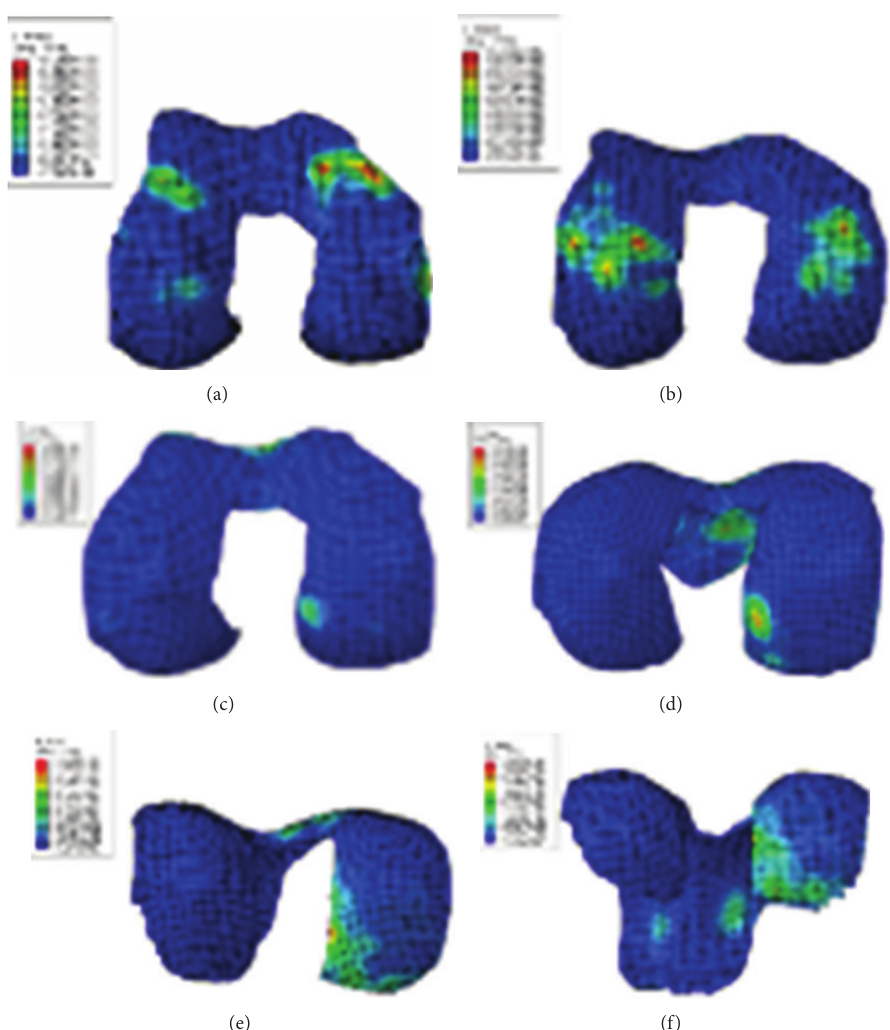
Figure 12: Contact stress of 0-30-60-90-130 degree flexion of tibiofemoral joint in FEA. (a) Stress distribution of 0 ∘ flexion. (b) Stress distribution of 30 ∘ flexion. (c) Stress distribution of 60 ∘ flexion. (d) Stress distribution of 90 ∘ flexion. (e) Stress distribution of 120 ∘ flexion. (f) Stress distribution of 130 ∘